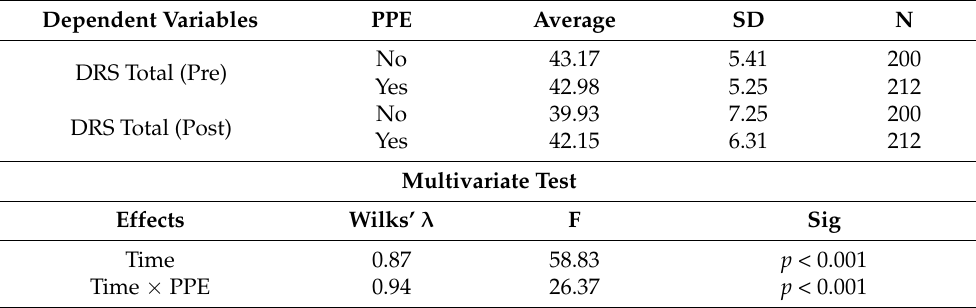
Figure 1. Average level of hardiness (total, commitment, control, and challenge) in the two subsamples of nurses taking care of COVID-19 patients and those who did not, with respect to time (i.e., pre- and post-pandemic first-wave effect). Table 9. Repeated measures ANOVA model of time (i.e., pre- and post-pandemic first-wave effect) and PPE effects on